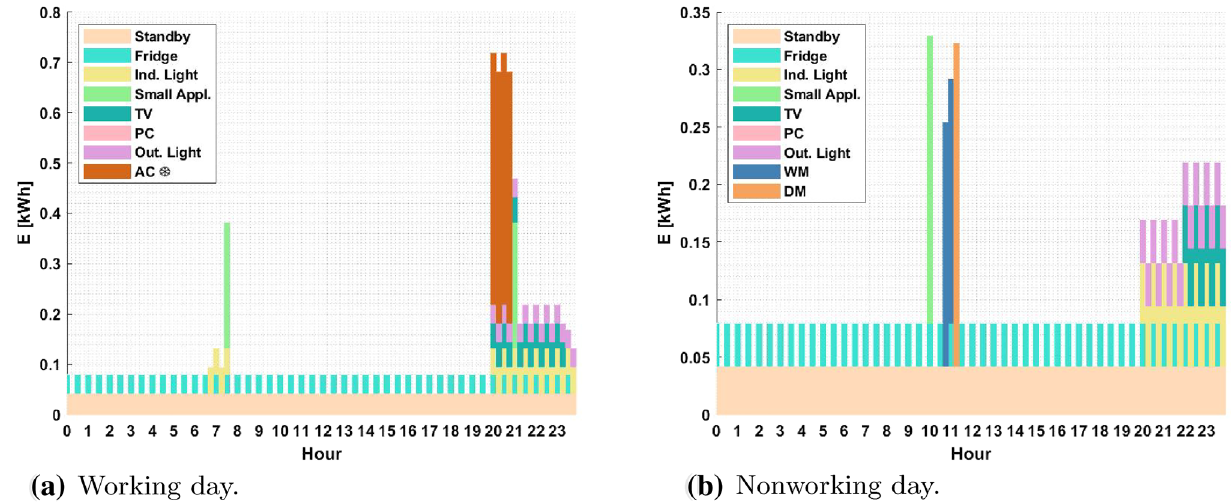
Fig. 6 Daily load profile, in each time interval, on the two significant days of August